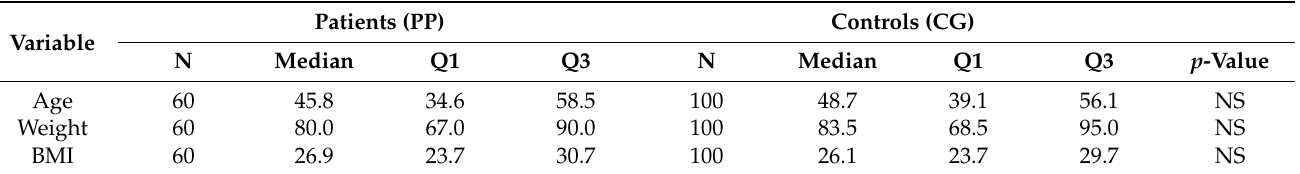
Table 1. Demographic findings expressed as medians with interquartile ranges